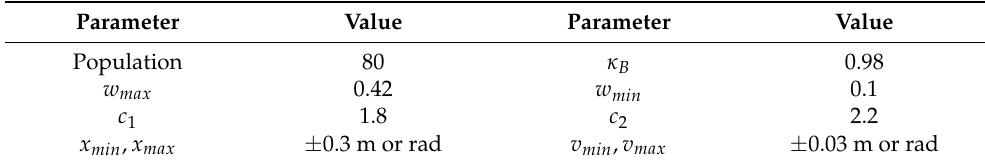
Table 2. SA–PSO parameters after optimization.